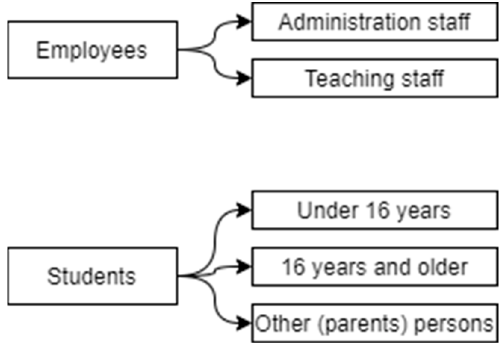
Figure 4. The five user groups divided into two more abstract classes. Processed data or/and used systems are the most technical top-level criteria. To reflect the data and system security, four sub-criteria are used: (4.1) data sensibility, (4.2) system access, (4.3) system vulnerabilities, (4.4) information technology management responsibility.